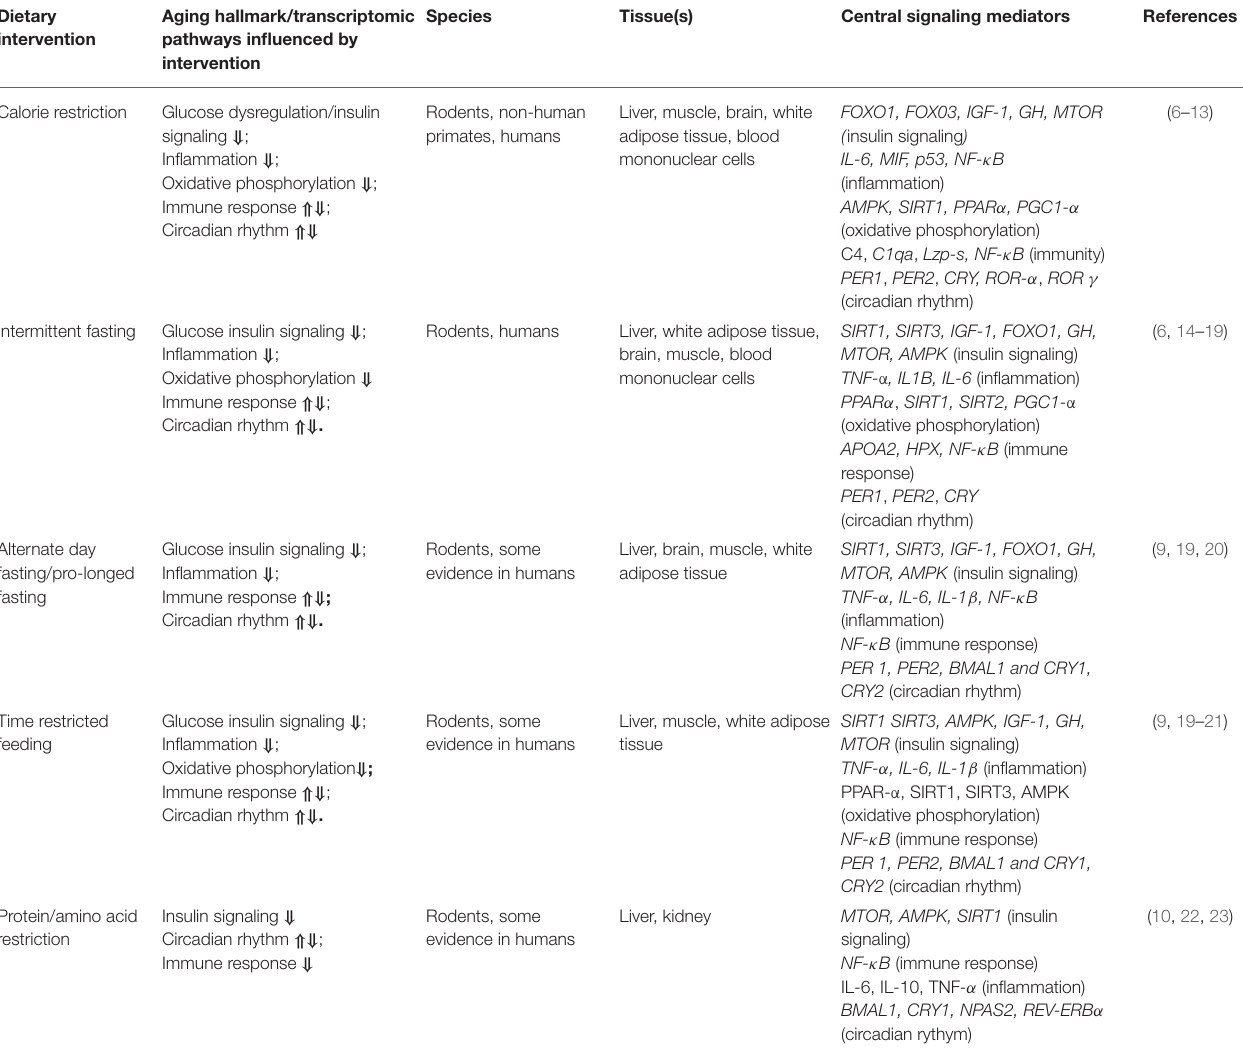
TABLE 1 | Commonalities among the effects of select healthy dietary interventions on biological hallmarks of aging in transcriptomic evidence. Dietary